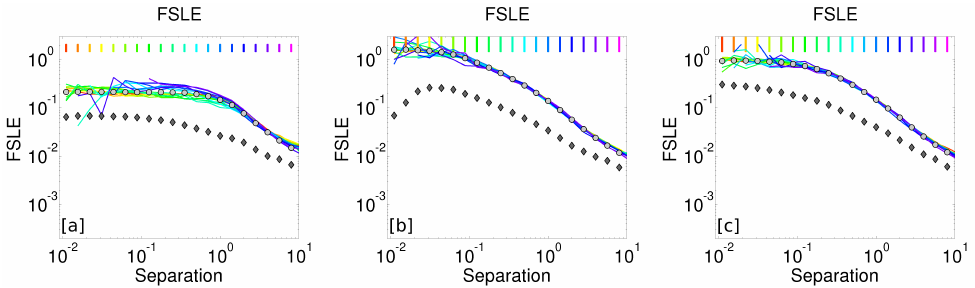
Figure 7. ( a ) FSLE ( λ ) computed using different initial conditions (Dirac δ distributions centred on the reference separation thresholds) for model run A. The initial separation is color coded. The dots and diamonds represent the FSLE and CVE, respectively, computed using the reference (Heaviside distribution) initial separation. The colored ticks on the top x-axis correspond to the color-coding of the plain lines. ( b ) Same as ( a ) for run B. ( c ) Same as ( a ) for run C.